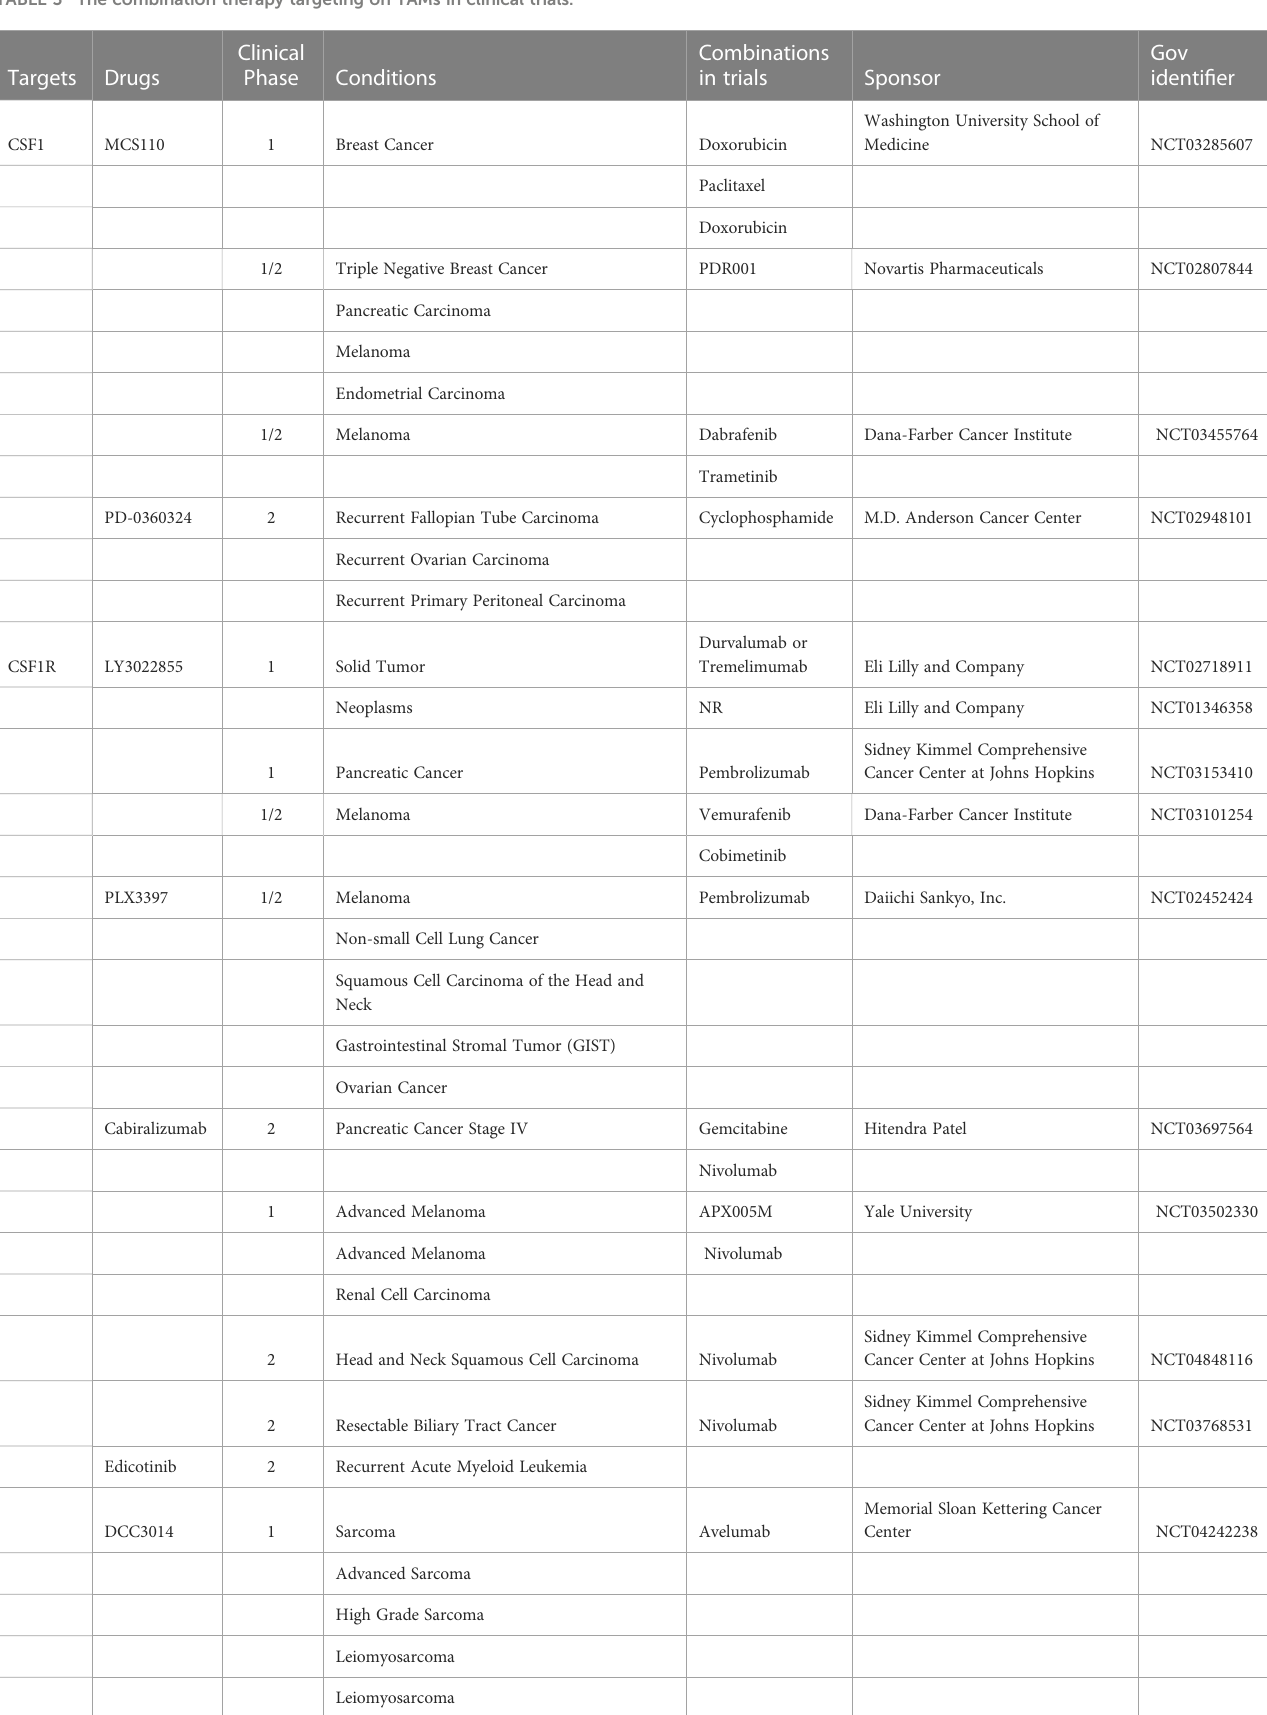
TABLE 3 The combination therapy targeting on TAMs in clinical trials.